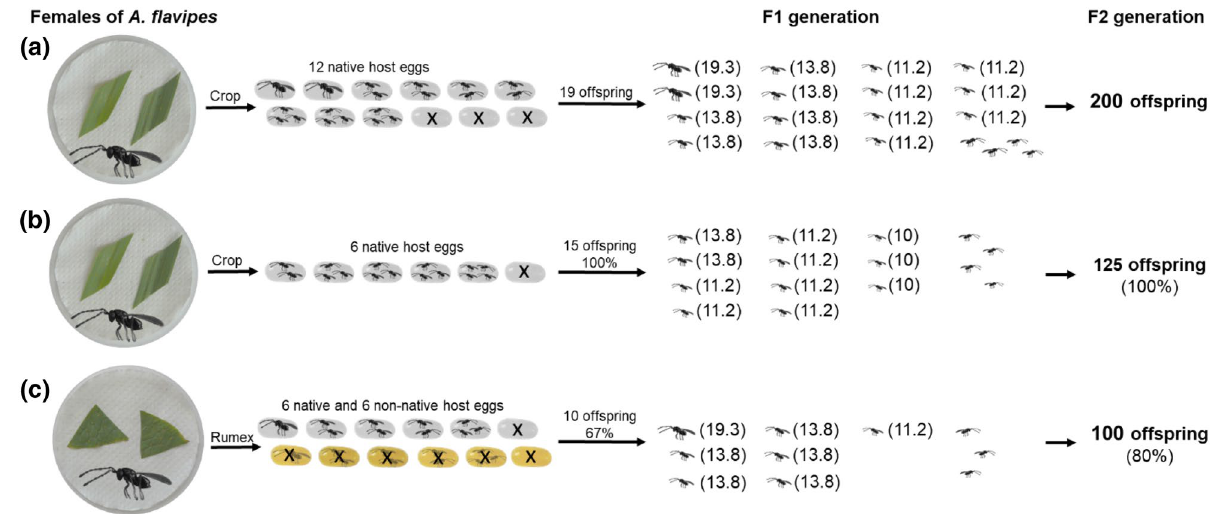
Figure 5. The relationship between different fitness characteristics in F1 generation and fertility in F2 generation for three groups of females in relation to occurrence of fictitious host in new environment of fictitious host plant; ( a ) females with 12 available native host on their native host plant (crop); ( b ) females with 6 available native host on their native host plant (crop) and ( b ) females with 6 available native host and 6 available fictitious host on the fictitious host plant ( Rumex ). (*The fertility values (shown in parentheses); The offspring sex ratio of A. flavipes is 3:1 (male:female) 46 ; females are shown as (left oriented) and males as (right